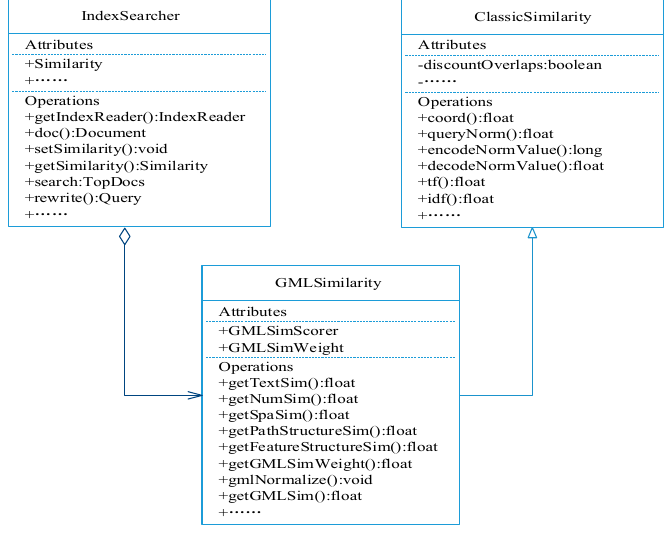
Figure 7. Structure of GMLSimilarity class.